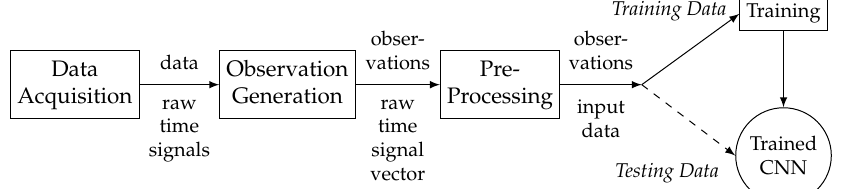
Figure 2. Overview of classification